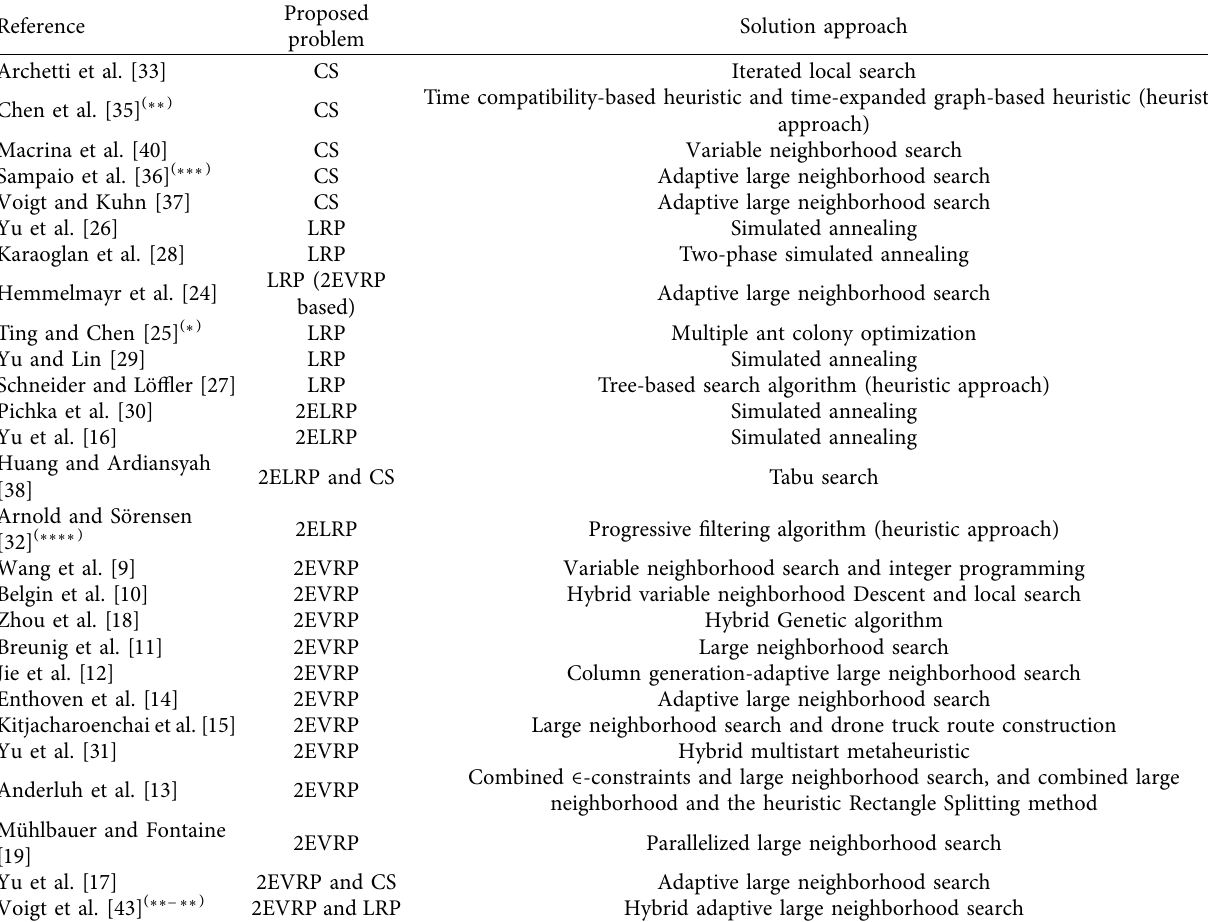
Table 1: Summary of metaheuristics and heuristics used for solving various variants of 2EVRP, LRP, and crowd-shipping (CS) problems.